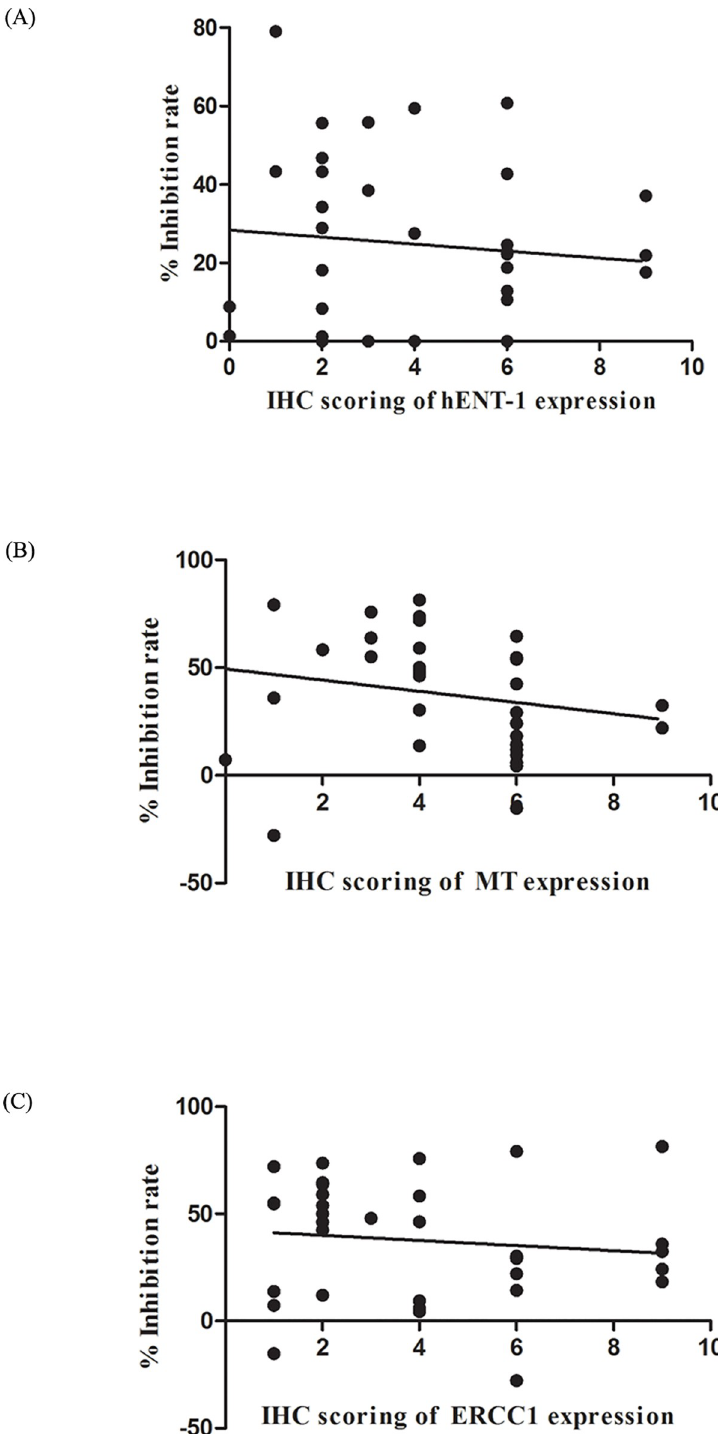
Fig 4. The correlation of expression of gemcitabine and cisplatin predictive biomarkers and %IR. X axis represents IHC scoring of hENT-1, MT and ERCC1 (A, B and C, respectively). Y axis represent %IR of 1500 μ g/ml of gemcitabine and 25 μ g/ml of cisplatin (A and B, C, respectively). (A) Elucidate the negative correlation of the expression of hENT-1 and %IR of 1500 μ g/ml of gemcitabine. (B) Elucidate the negative correlation of the expression of MT and %IR of 25 μ g/ml of cisplatin. (C) Illustrate the negative correlation of the expression of ERCC1 and %IR of 25 μ g/ml of cisplatin.